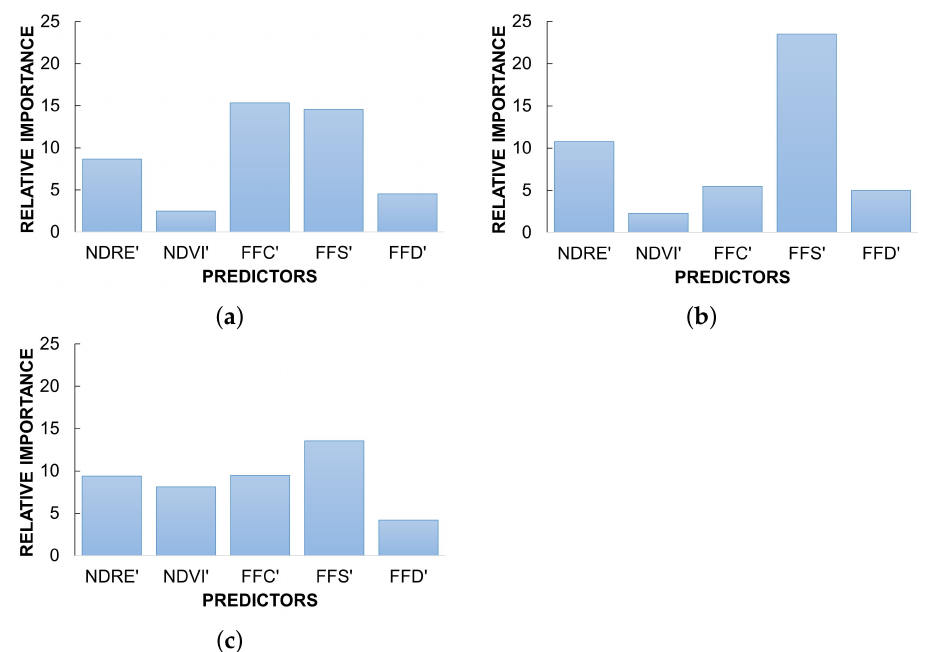
Figure 10. Characteristics accumulated which most influenced forecasting crop yield model genera- tion using the DTE-Bag method, for: ( a ) 6; ( b ) 4; and ( c ) 2 WBH.